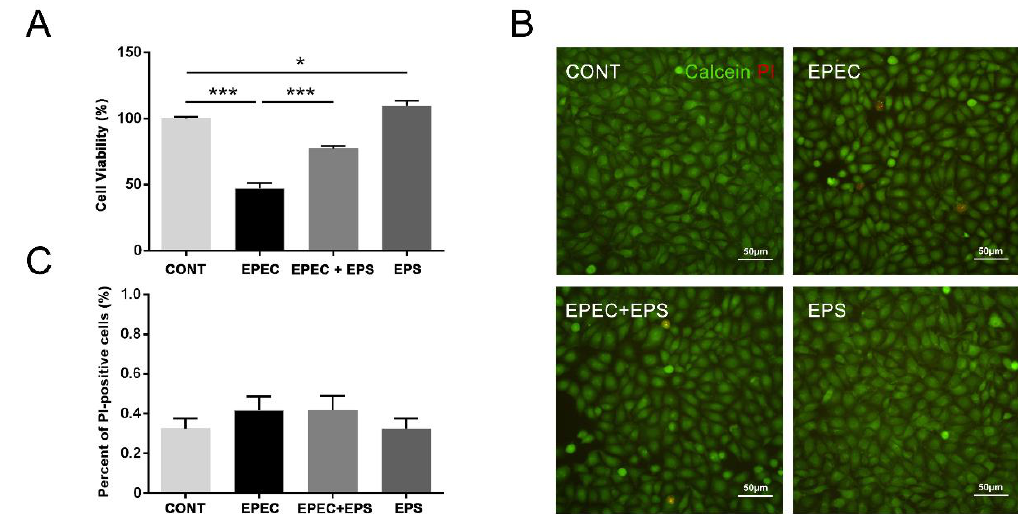
Figure 1. Pretreatment with EPS reduced the cell death induced by EPEC. ( A ) Cell viability was detected through the CCK-8 assay. CCK-8, Cell Counting Kit-8; The data was presented as mean ± SEM ( n = 3), * p < 0.05, *** p < 0.001. ( B ) Representative image of IPEC-J2 cells stained by Calcein-AM/PI was showed. Scale bar, 50 µm. ( C ) The percentage of PI-positive cells was presented as mean ± SEM ( n = 3), there was no difference among four groups.